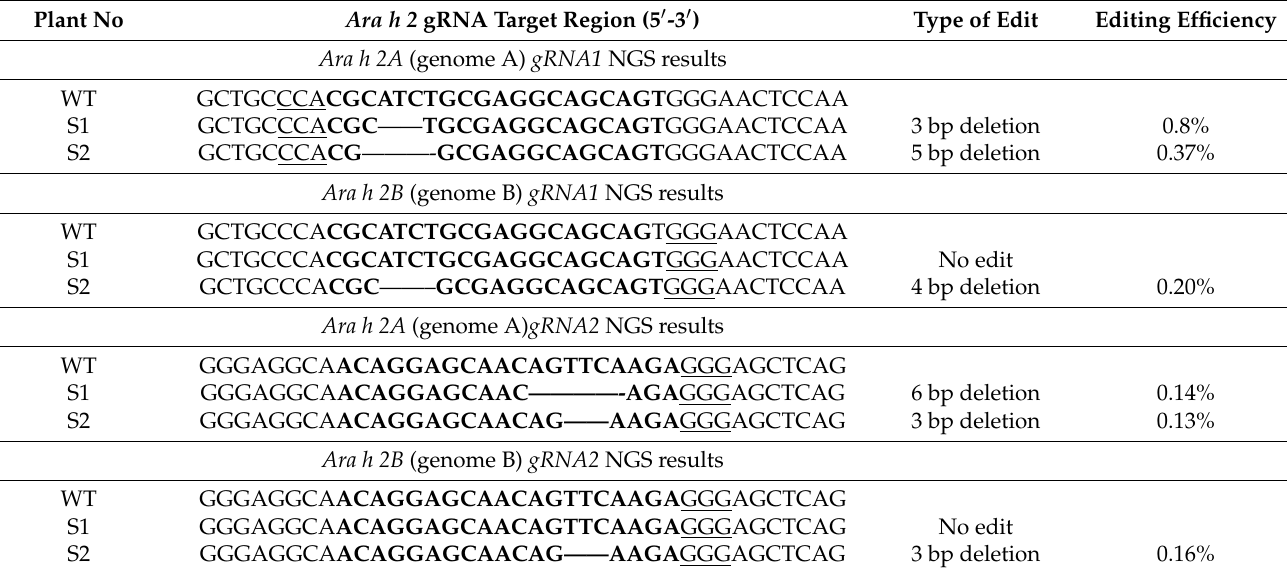
Table 1. Mutation analysis by targeted deep sequencing in Ara h 2